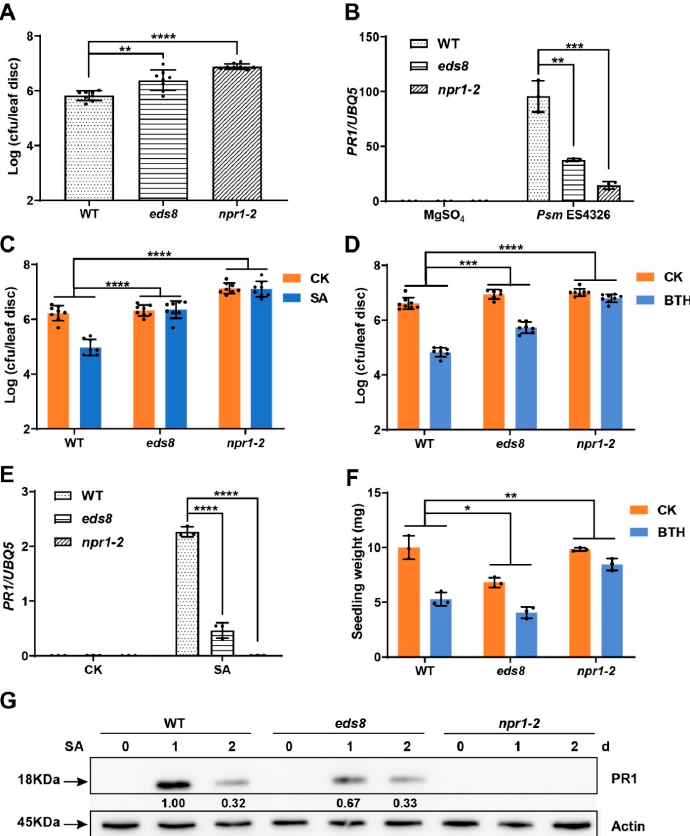
Figure 1. SA related phenotypes of the eds8 mutant. ( A ) The eds8 mutant was more susceptible to Psm ES4326. Three-week-old plants were inoculated with Psm ES4326 (OD 600 = 0.0001) and pathogen growth was determined three days post inoculation (dpi). Significant difference was detected using Student’s t -test. Data are shown as mean ± SD ( n = 8). ( B ) The expression of PR1 after Psm ES4326 inoculation. Samples were collected 1 dpi. Significant difference was detected using Student’s t -test. Data are shown as mean ± SD ( n = 3). SA ( C ) or BTH ( D ) induced resistance to Psm ES4326 in WT, eds8, and npr1 mutants. Three-week-old plants were sprayed with SA, BTH or water one day before pathogen infiltration (OD 600 = 0.001), and pathogen growth was determined three days later. Significant difference was detected by two-way ANOVA. Data are shown as mean ± SD ( n = 8). ( E ) SA induced expression of PR1 in WT, eds8, and npr1 mutants. Twelve-day-old seedlings were sprayed with SA or water, and samples were collected one day after treatment. Significant difference was detected using Student’s t -test. Data are shown as mean ± SD ( n = 3). ( F ) BTH induced growth inhibition assay. Ten-day-old seedlings were treated with 600 µ M BTH or water (CK) for five days, and then the seedlings were weighed. Significant difference was detected by two-way ANOVA. Data are shown as mean ± SD ( n = 3). ( G ) The protein levels of PR1 in WT, eds8, and npr1 mutants after SA treatment. Twelve-day-old seedlings were sprayed with SA or H 2 O (CK) and samples were collected at 0, 1, or 2 days after treatment for Western blot using anti-PR1 antibody. The relative PR1 levels in different samples were compared with PR1 level in WT sample treated with SA for one day. The levels of Actin were also detected as internal controls. All these experiments were repeated three times with similar results. * p < 0.05; ** p < 0.01; *** p < 0.001; **** p <